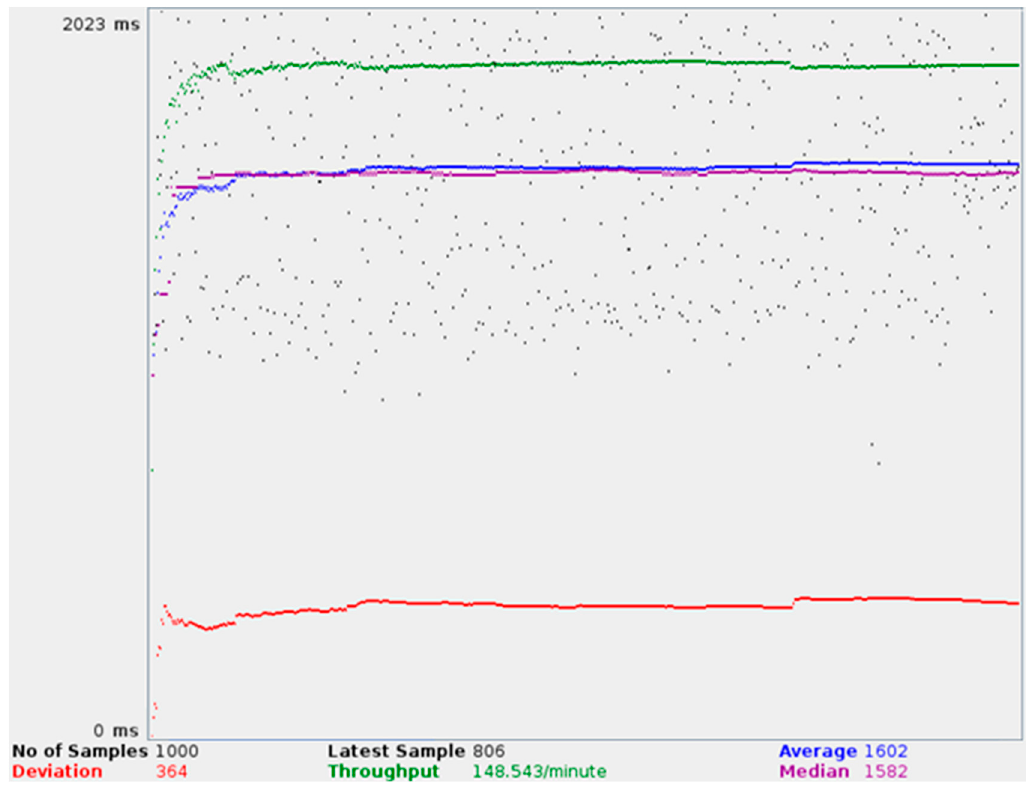
Figure 11. Performance results obtained in middleware tests, as shown in [12].